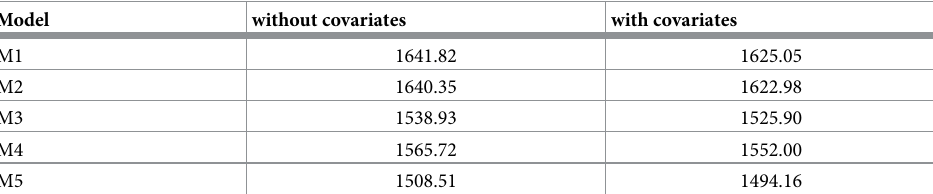
Table 1. Model Fit DIC